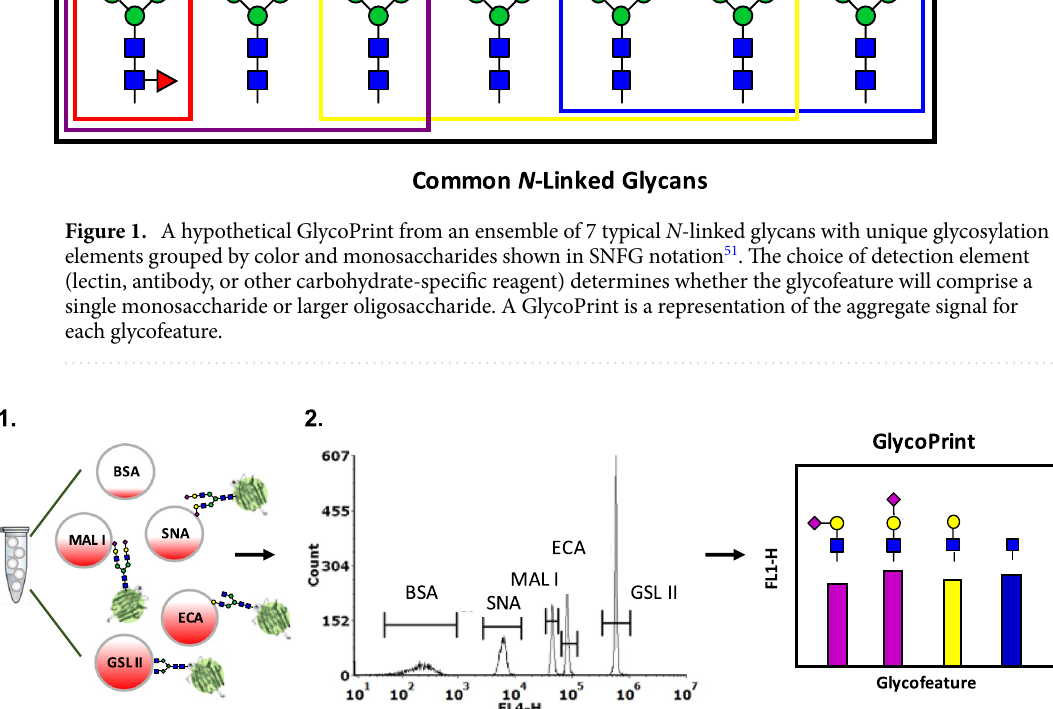
Figure 2. GlycoSense workflow. 1 . A fluorescently labeled glycoprotein, or glycoprotein with a fluorescently labeled secondary detection reagent, is incubated with multiplex GlycoSense microspheres in suspension then run on a flow cytometer. 2 . Microsphere peaks are determined by red (633/640 nm excitation, 670 nm emission, FL4) fluorescence while bound glycoprotein is detected by green (488 nm excitation, 525 nm emission, FL1) fluorescence. Relative median green fluorescence is then calculated for each microsphere and presented as a